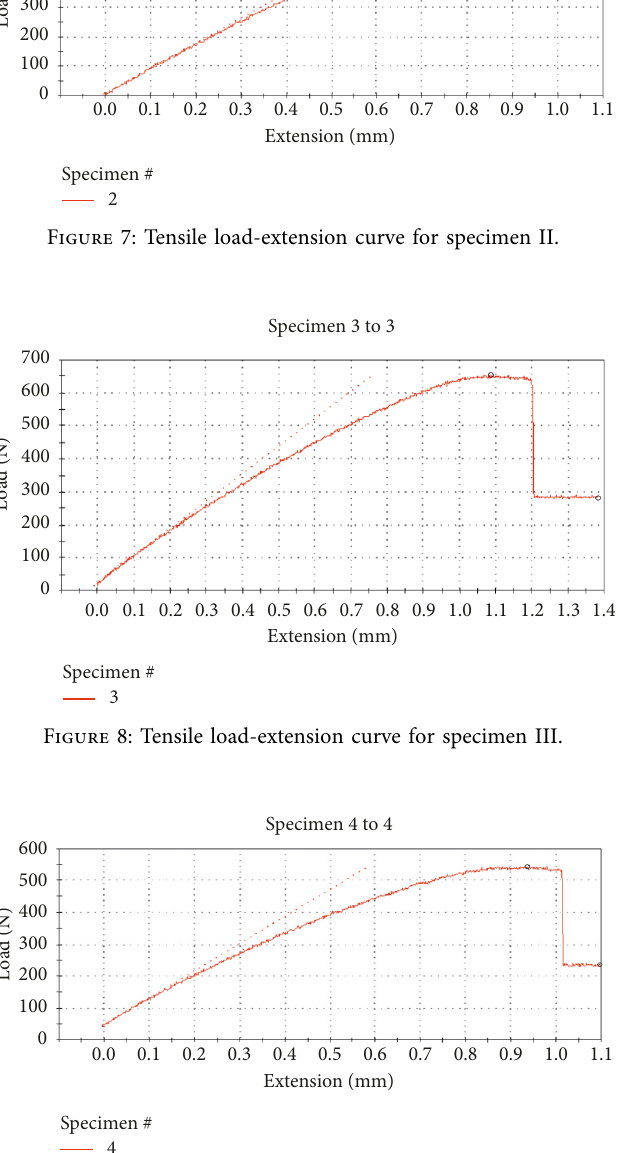
Figure 9: Tensile load-extension curve for specimen